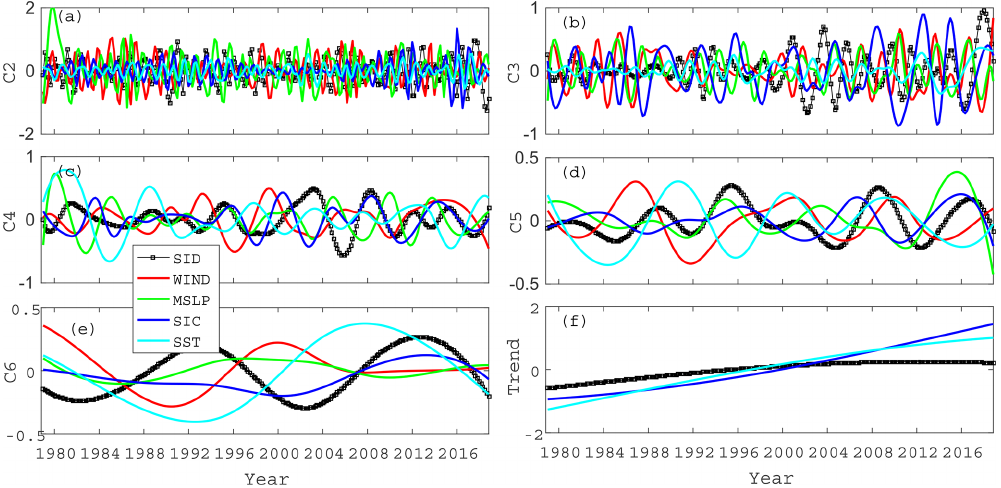
Figure 9. The IMF modes (a–e) and trend components (f) after EEMD of the second sea ice EOF temporal coefficient and each environmental parameter. (For each environmental parameter, only the EOF component marked with an asterisk is